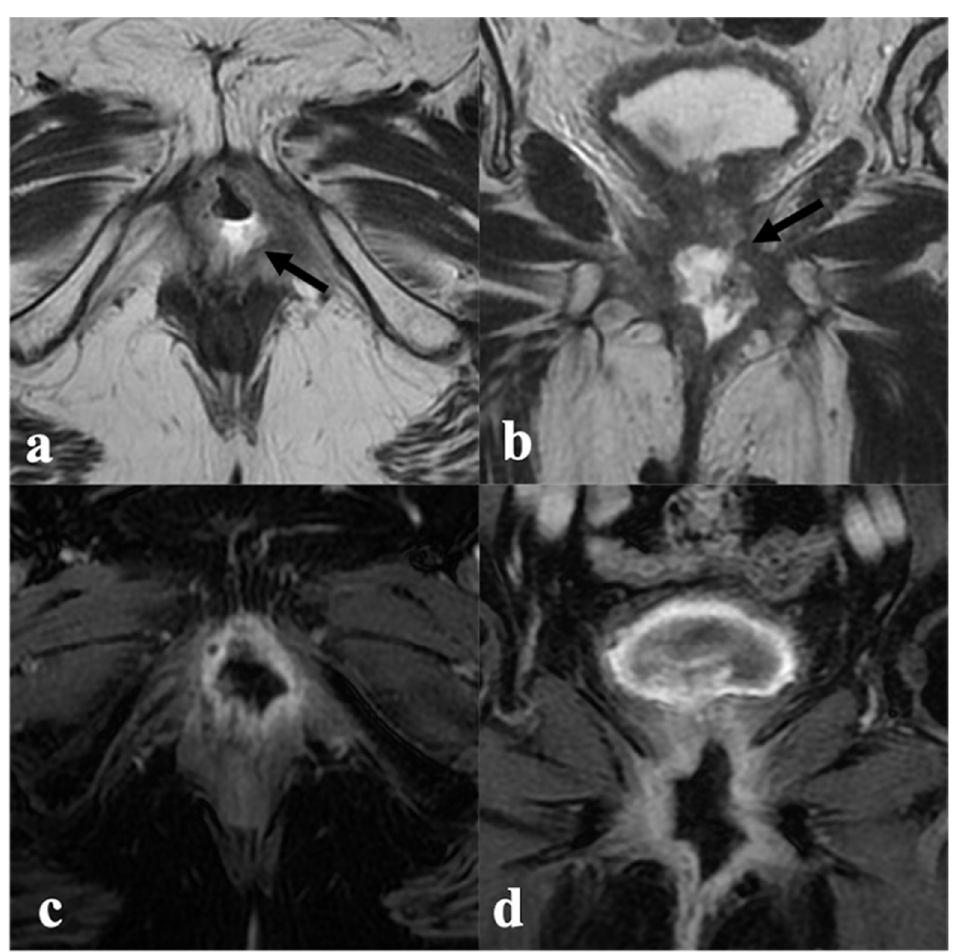
Figure 9. Urethrovaginal fistula after CRT. An 87-year-old patient who received multiple treatments (both surgery and CRT) for recurrent vulvar cancer, presenting with tissue loss in the urethrovaginal space resulting in a fluid-filled communication between the urethra and the lower third of vagina (( a , b )—black arrow) with marked peripheral enhancement ( c , d ), consistent with a fistula.